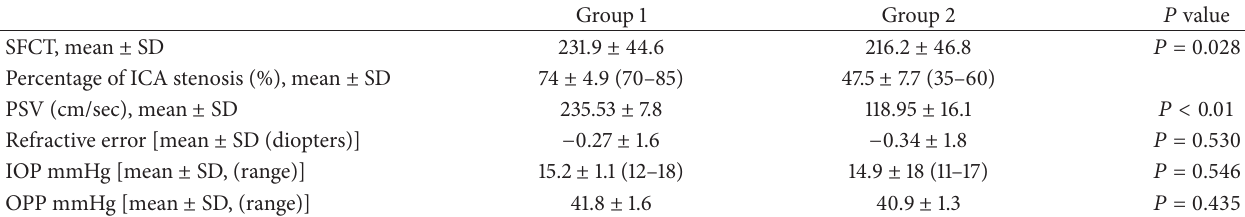
Table 2: Subfoveal choroidal thickness and other clinical measurements in both groups.